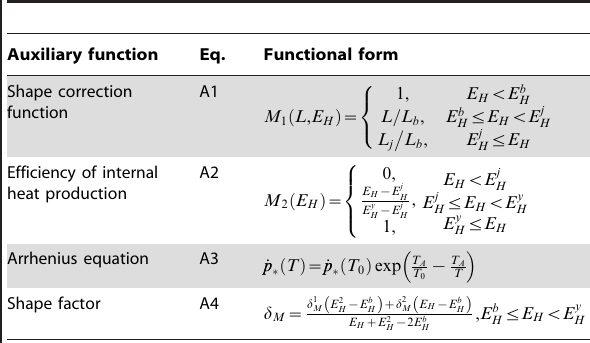
Table 4. Dynamic energy budget of Pacific bluefin tuna III: auxiliary